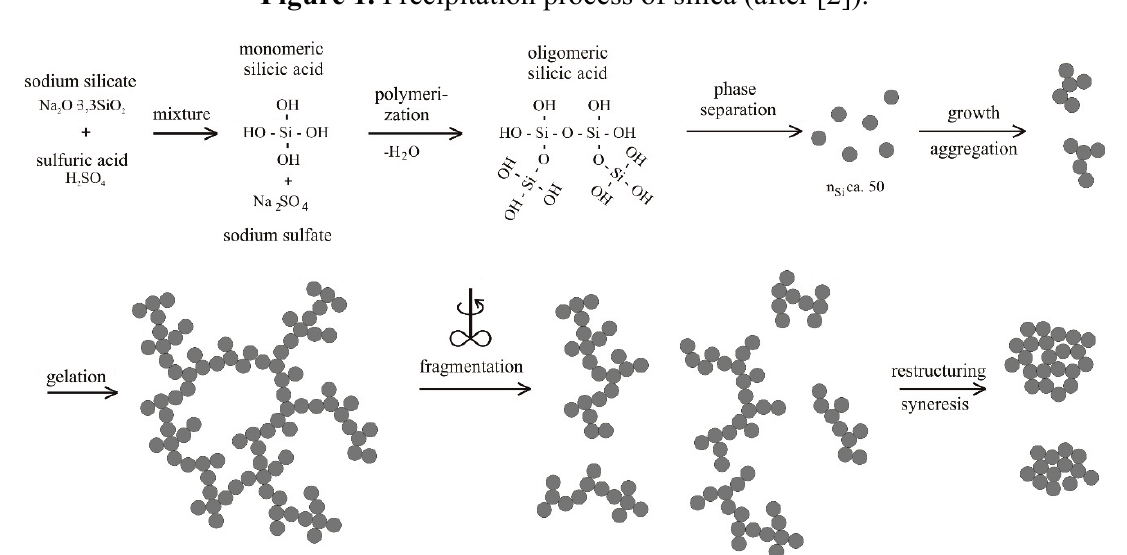
Figure 1. Precipitation process of silica (after